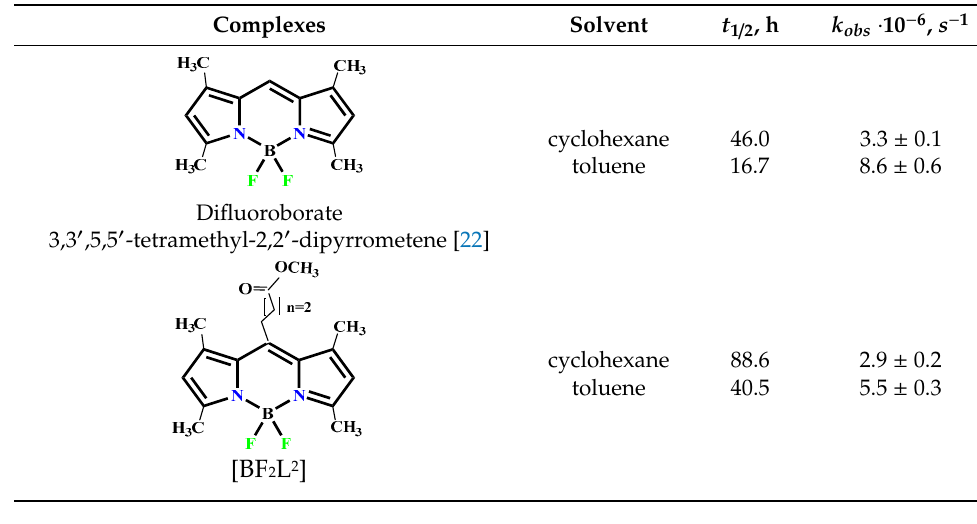
Table 2. Quantitative characteristics of BODIPYs photostability in organic solvents.